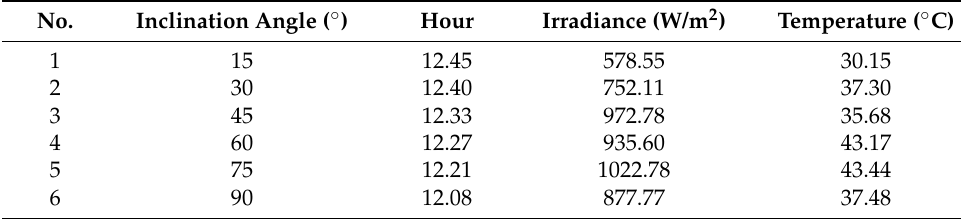
Table 5. The measurement conditions for a white substrate.